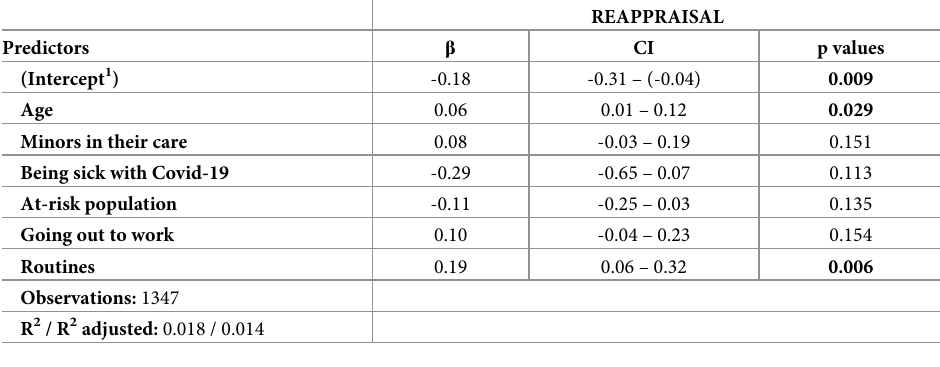
Table 15. Regression analysis relating to re-evaluation strategy in the